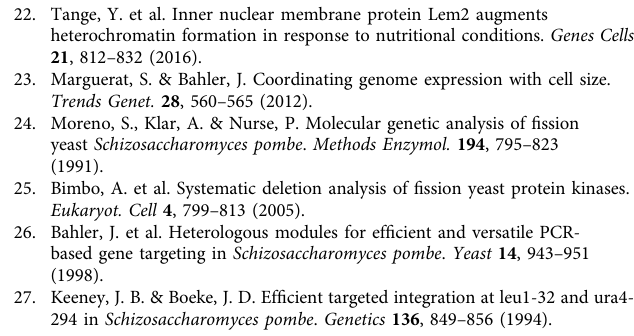
Statistics . For data displayed in box-and-whisker diagrams individual data points are shown in dot plots in Supplementary Figs. 9 and 10. For pairwise comparisons, normality of the data of each distribution was determined using the D ’ Agostino and Pearson test, and then unpaired two-tailed Student ’ s t- tests, or Mann – Whitney tests when appropriate, were carried out to determine signi fi cance. Details in fi gure